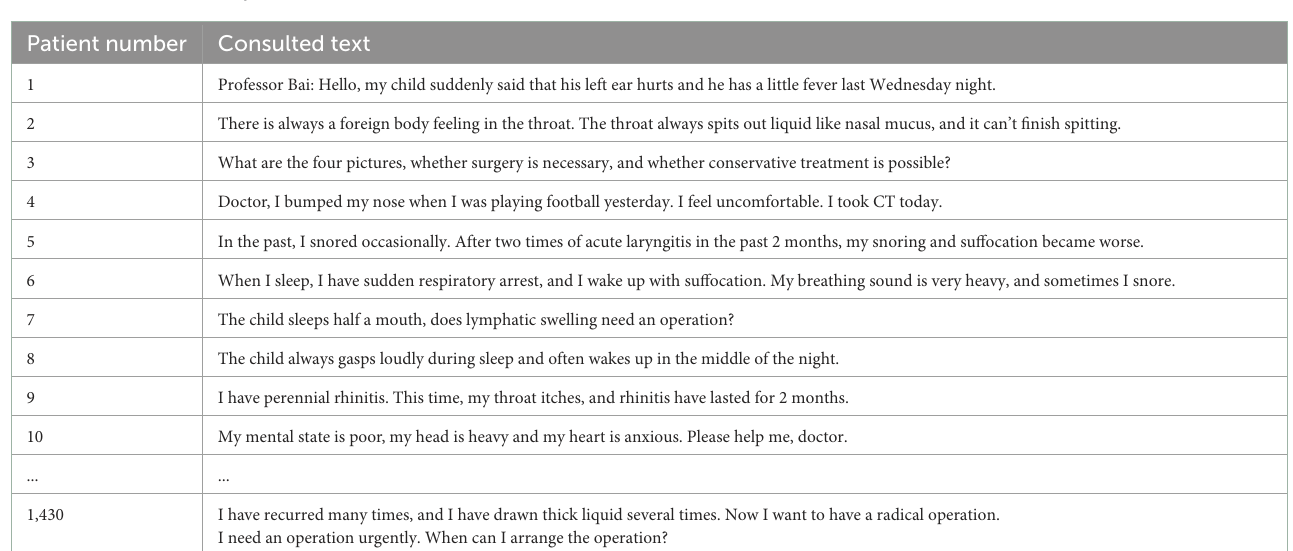
TABLE 4 Patients’ main complaint